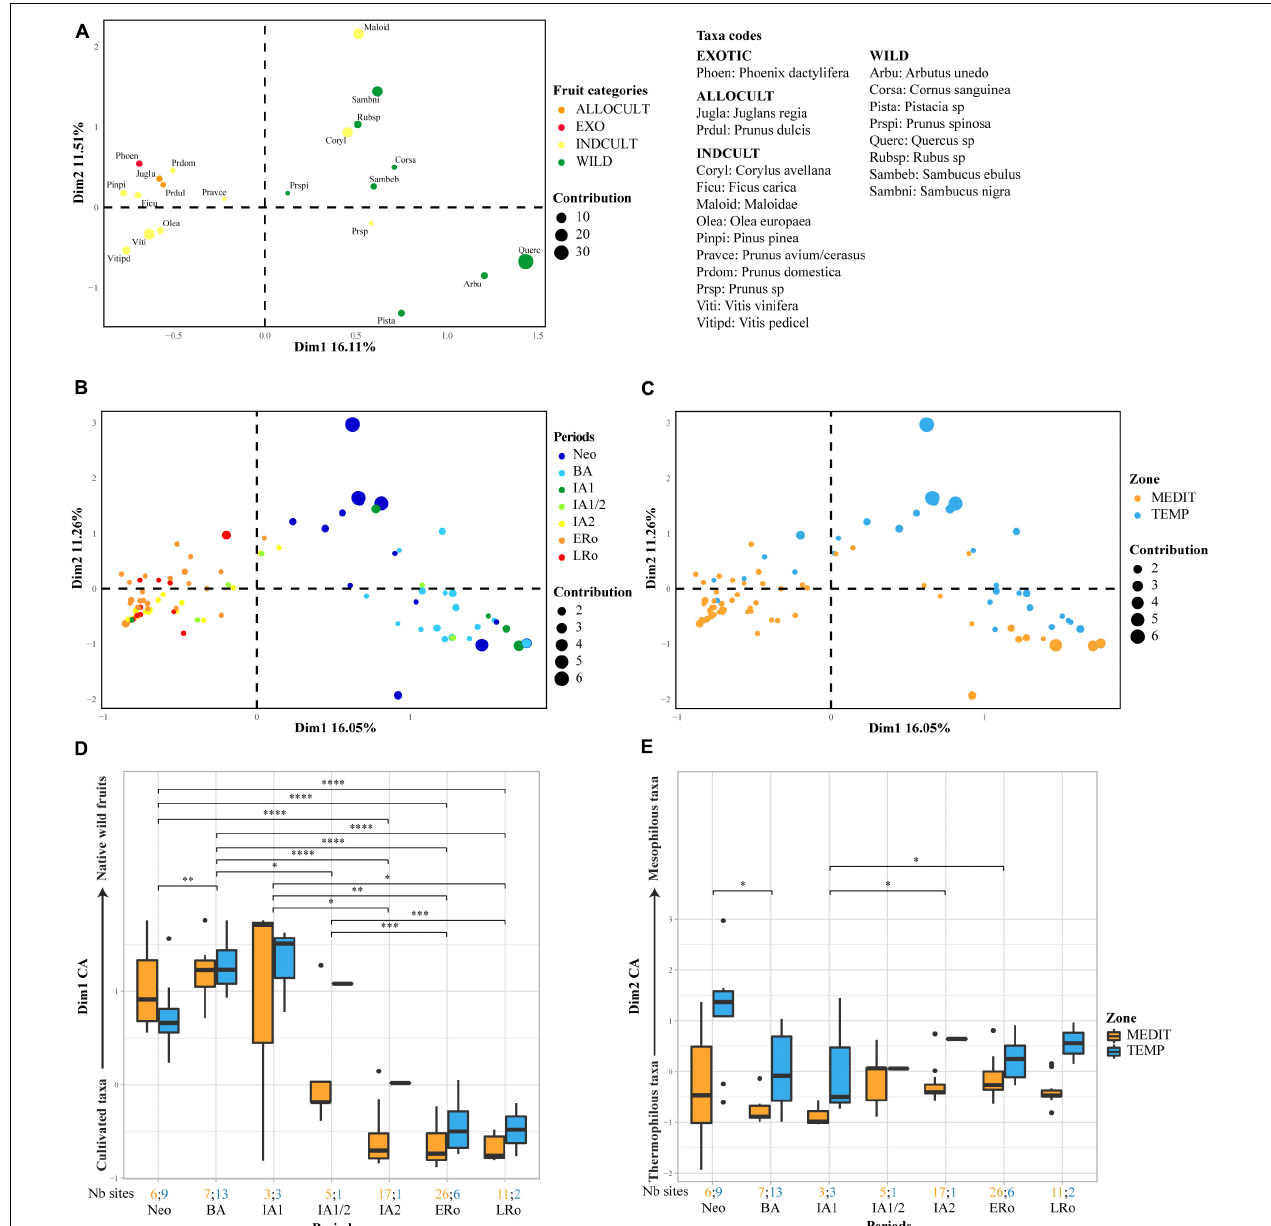
FIGURE 5 | Correspondence factor analysis on charred fruit remains. First biplot of the correspondence factor analysis on log-transformed raw counts of charred fruit remains, (A) plot of taxa, (B) plot of sites according to main archeological periods, (C) plot of sites according to bioclimatic zones. Box plots showing the distribution of the sites on (D) axis 1 and (E) axis 2 of the CFA in relation to cultural periods and bioclimatic zones. Axis 1 displays a discrimination between cultivated taxa to the left and native wild fruits to the right. Axis 2 displays a discrimination between thermophilous taxa in the lower part and mesophilous taxa in the upper part. The number of sites for each period and bioclimatic zone is provided at the bottom of the graph. Statistical significances of the Wilcoxon tests are indicated on the box plots, only when the result is significant (* p ≤ 0.05; ** p ≤ 0.01; *** p ≤